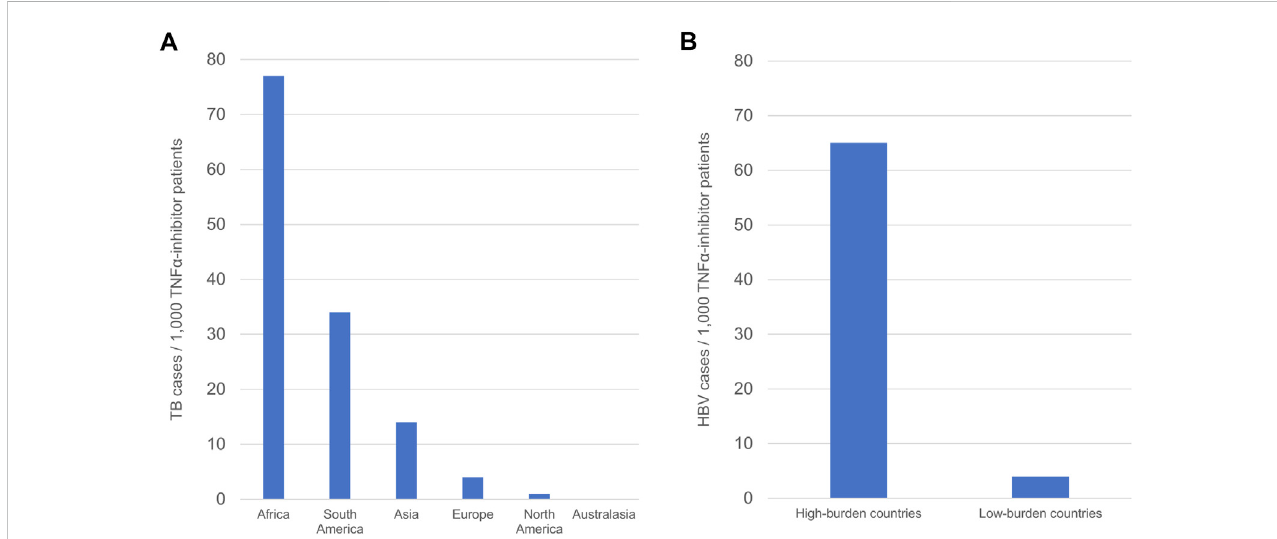
FIGURE 2 Regional differences in the frequency of TB and HBV infection in TNF α -inhibitor patients. (A) Continental differences in TB frequency in TNF α -inhibitor patients. (B) Differences in HBV frequency according to regional burden. Frequency is de fi ned as number of cases/1000 TNF α -inhibitor patients.